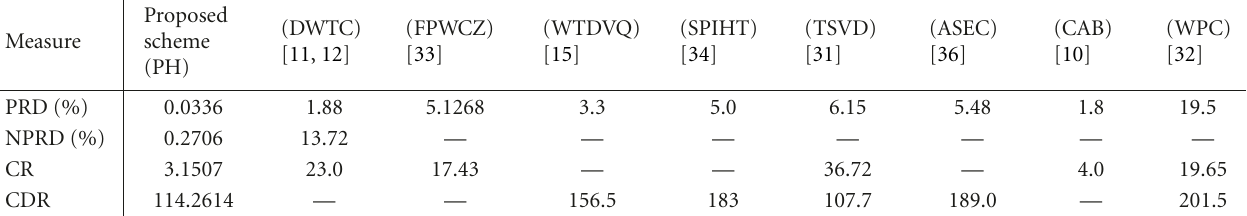
Table 10: Record MIT-ADB 119: performance comparison results with di ff erent ECG compression methods. ASEC denotes analysis by synthesis ECG compressor.